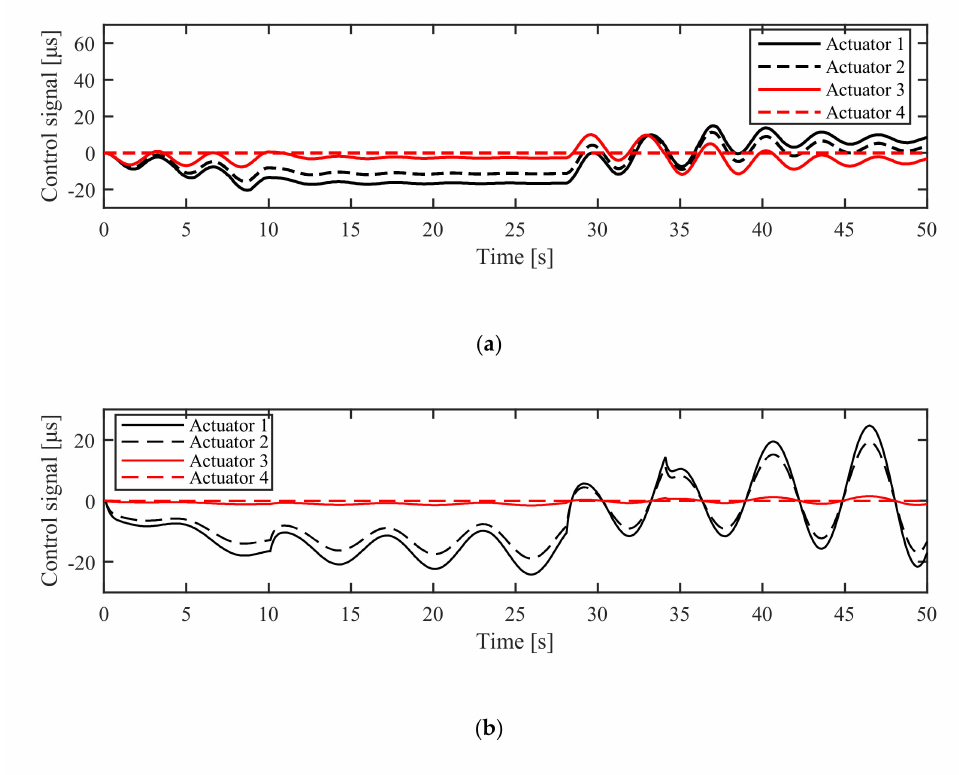
Figure 14. The control signal in AM mode: ( a ) Proposed controller; ( b ) PID.